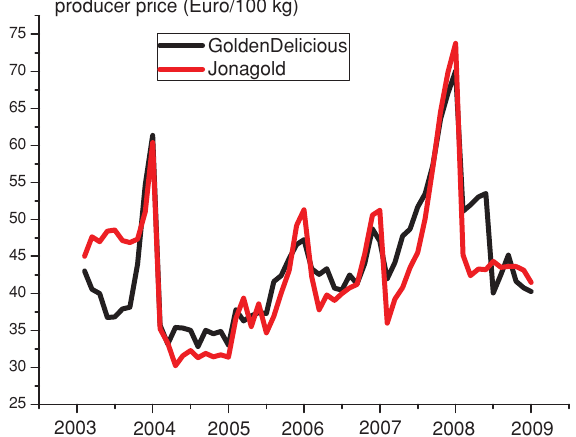
Figure3. The time series of producer prices of two important apple-varieties in Germany